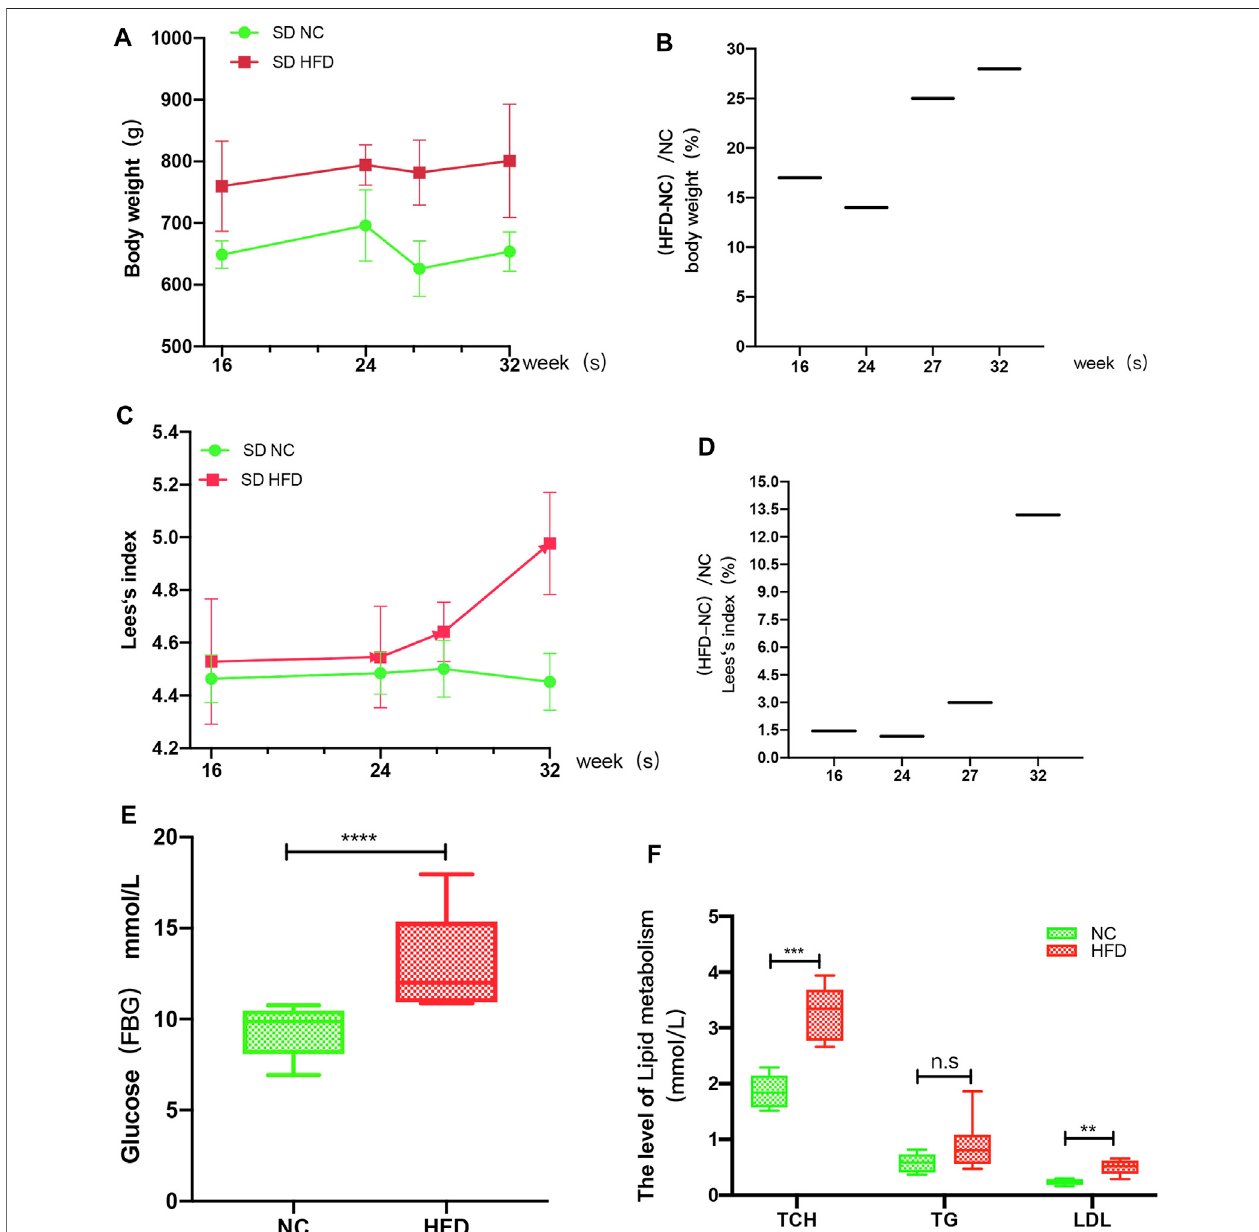
FIGURE6| HFDratmodel. Therats ’ weights,bodylengths,FBG levelsand bloodlipid (TG,TCH,and LDL)levels weremeasured at16,24,26,and32 weeks. (A) The weight gain of the HFD rats at 16, 24, 27, and 32 weeks was signi fi cantly greater than that of the NC rats. (B) The percent weight gain of the HFD rats at 16, 24, 27, and 32 weeks was 17, 14, 25 and 28%, respectively. (C) Lee ’ s index of the rats. (D) The Lee ’ s index values were increased by 1.457, 1.16, 2.99, and 13.2% at 16, 24, 27, and 32 weeks, respectively. (E) At 27 weeks, the FBG levels were signi fi cantly higher in the HFD rats than in the NC rats. (F) At 27 weeks, the TCH and LDL levels of the HFD group were signi fi cantly greater than those of the NC group, while there was no signi fi cant difference in TG level between the groups. The results are presented as the mean ± standard deviation ( t -test; n (cid:2) 6 in each group). * p < 0.05,** p < 0.01,*** p < 0.001,**** p < 0.0001, n. s., not signi fi cant.